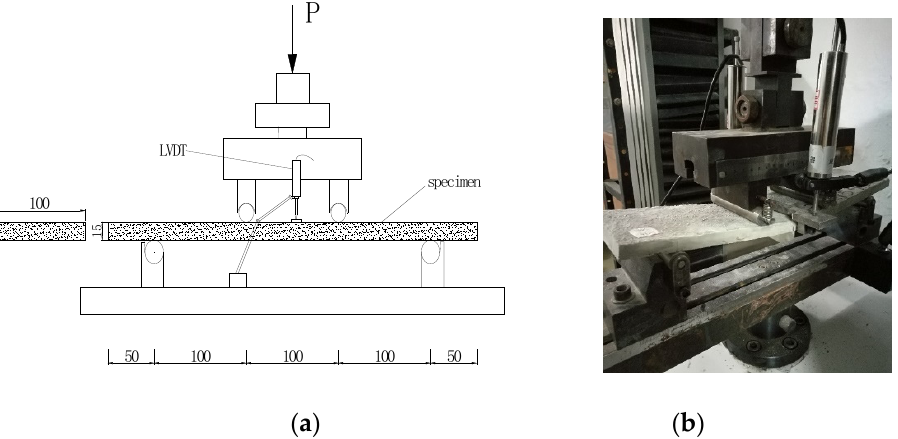
Figure 3. Four-point bending test: ( a ) Schematic representation (dimension in mm) and ( b ) Photo of test.